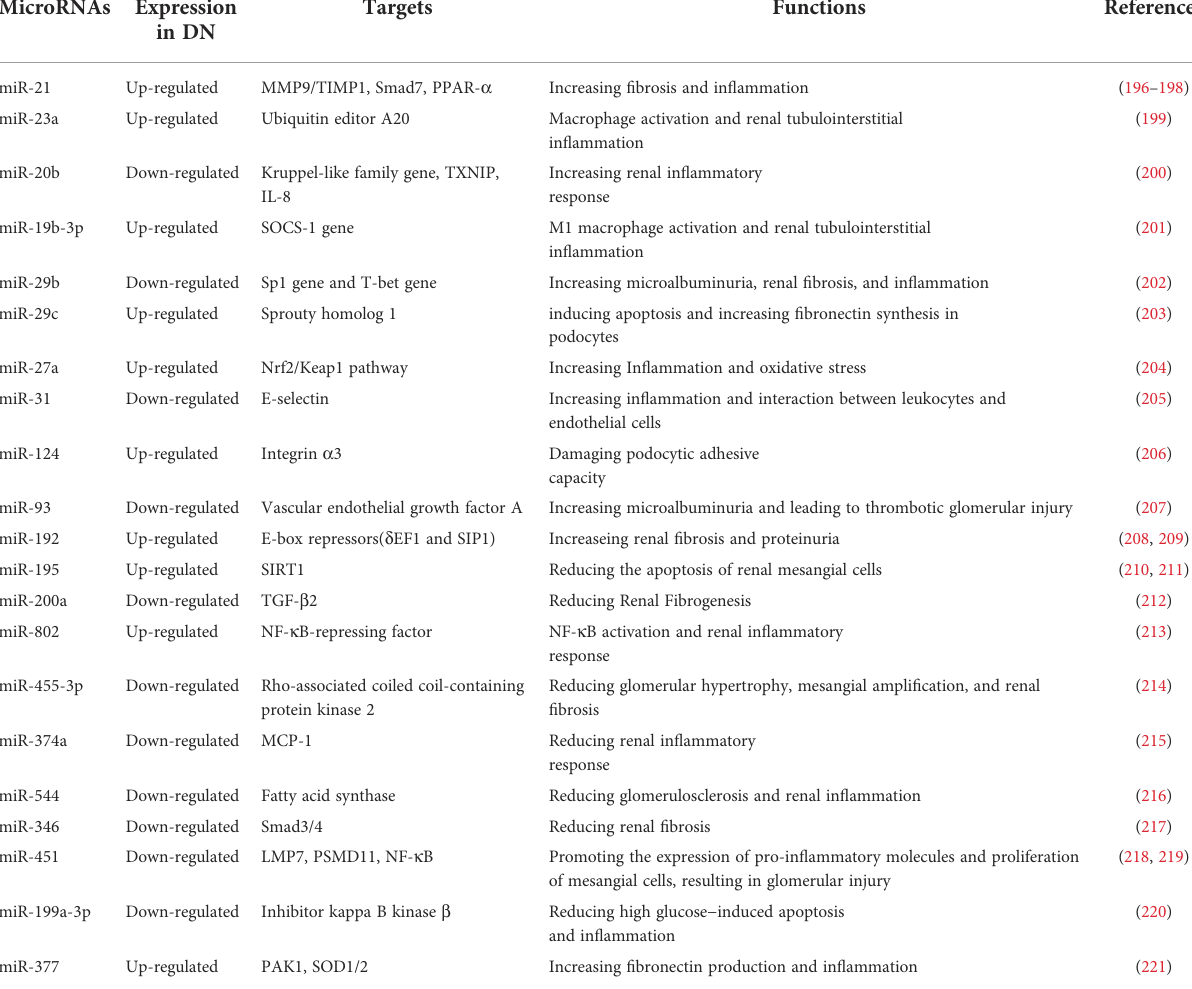
TABLE 3 The miRNAs involved in regulating the immune mechanism of DN. MicroRNAs Expression in